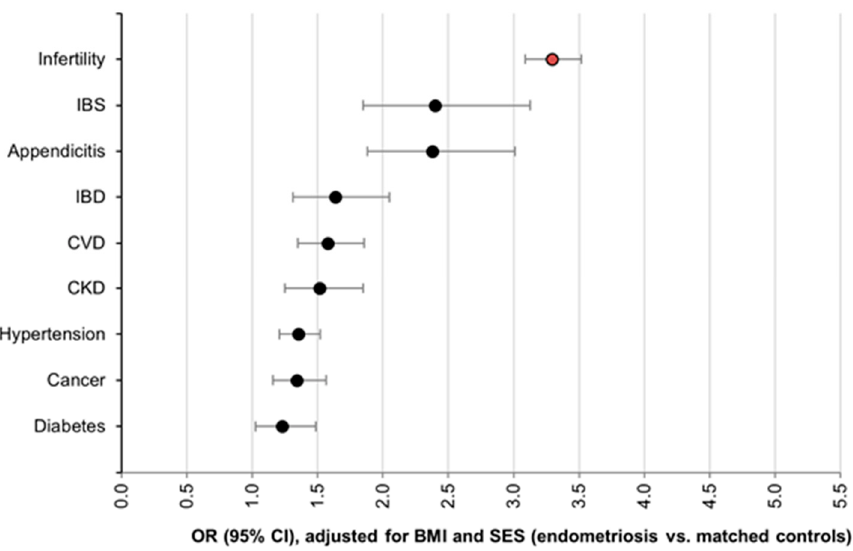
Figure 1. Odds ratios for comorbidities among women diagnosed with endometriosis compared to matched controls, adjusted for SES and BMI (lifetime prevalence).